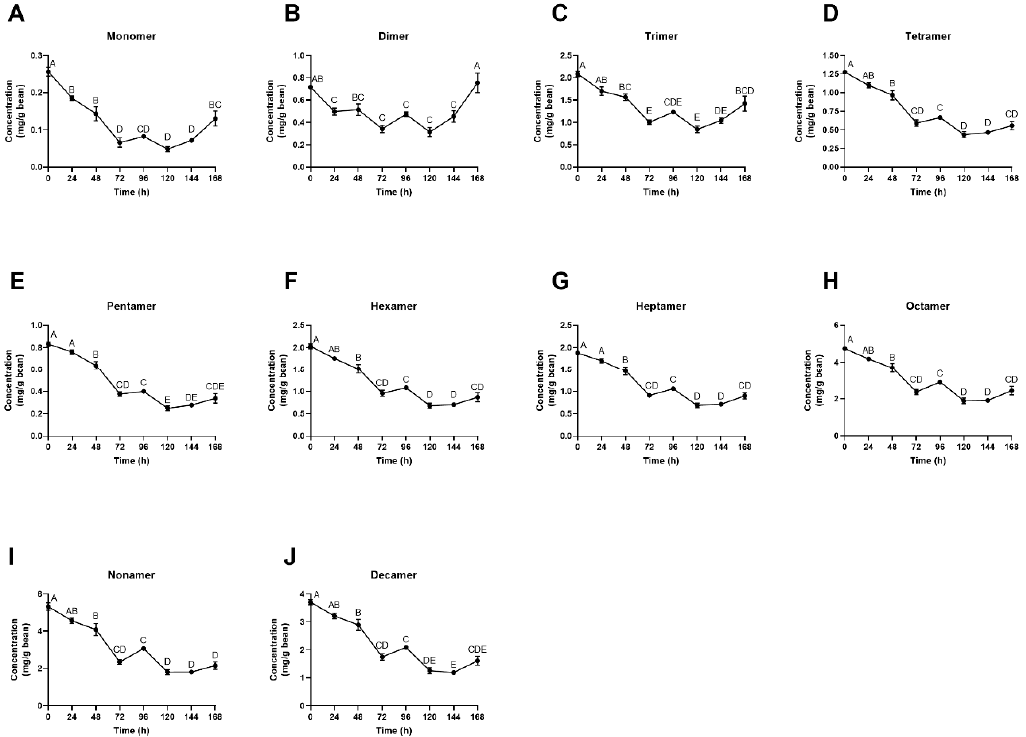
Figure 6. ( A – J ) Individual polyphenol concentrations by mean degree of polymerization (mDP) over the 168-h fermentation as quantified by HILIC UPLC-MS/MS and expressed as mg/g cocoa bean. Values are presented as the mean ± SEM of fermentation replicates. Significance between time points was determined by one-way ANOVA and Tukey’s HSD post-hoc test ( p < 0.05). Time points with different letters are significantly different within values.